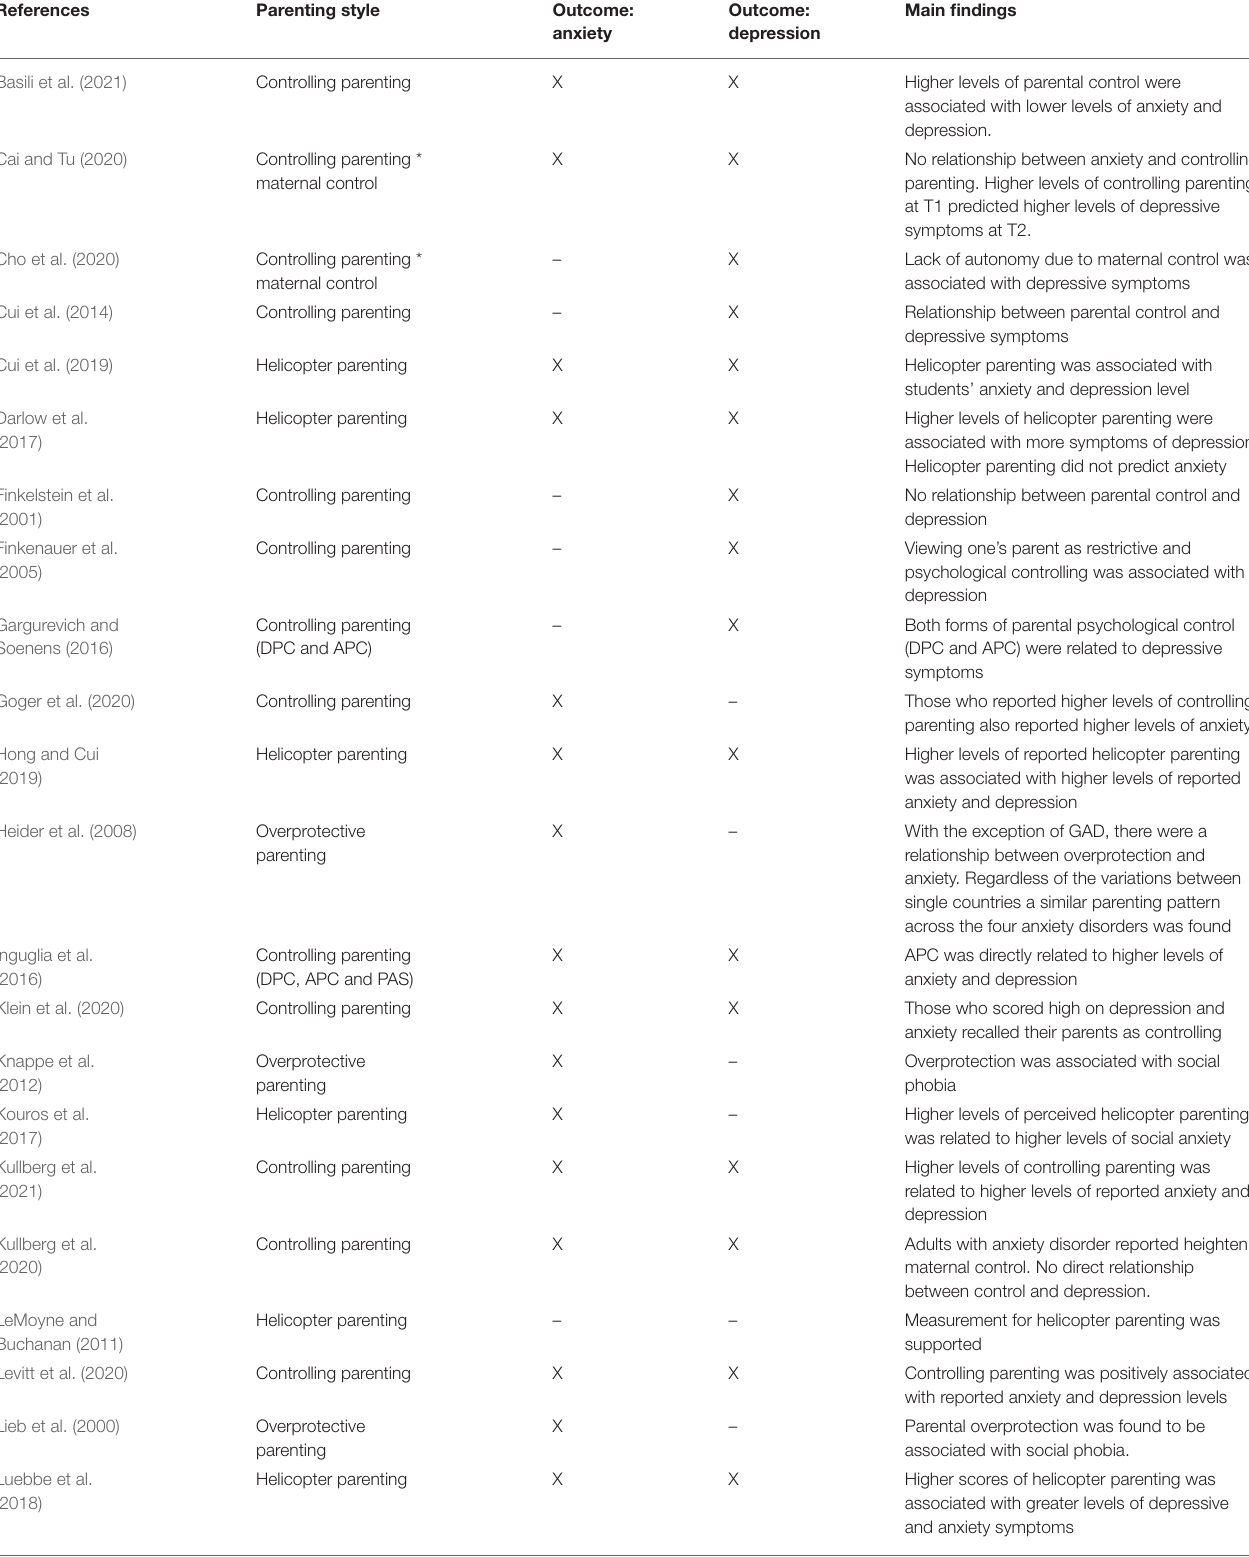
TABLE 4 | Overview of parenting style and outcome examined as well as main